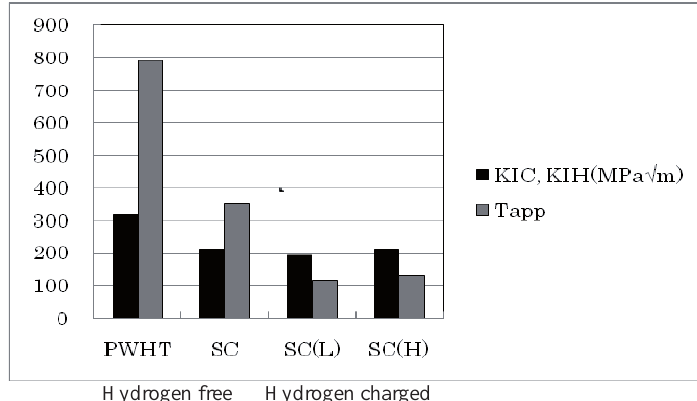
Fig.7. Comparison of fracture toughness and the tearing modulus at an upper shelf temperature of 393 K (120 (cid:864) ).